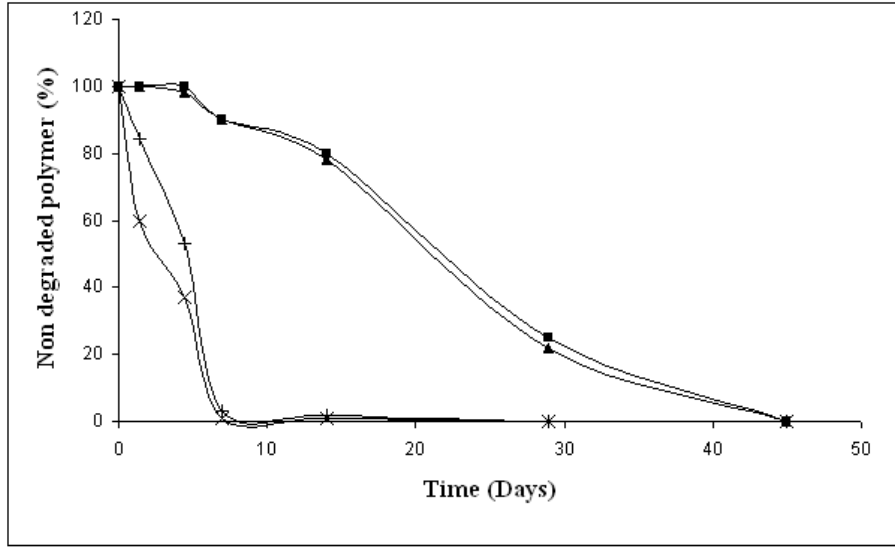
Figure 5. Evolution of respectively non degraded PLA part and non degraded starch part of co-extruded material during film degradation in activated vermiculite ( (cid:99) ), (x) and in no inactivated vermiculite ( (cid:132) ),